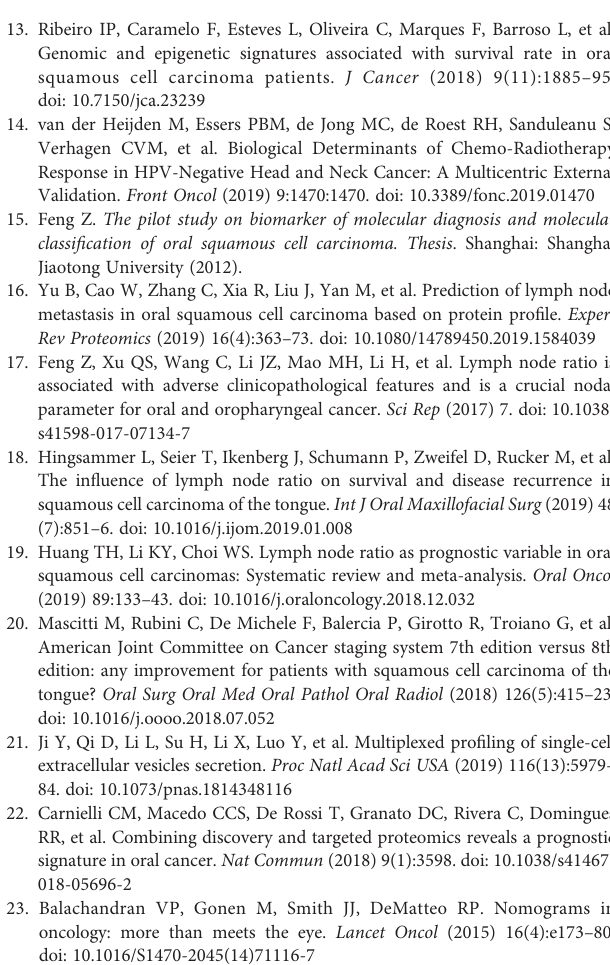
Supplementary Figure 1 | PPI networks between CDKN2A and PLAU based on the STRING database Supplementary Figure 2 | GSEA of CDKN2A and PLAU based on the GSEA